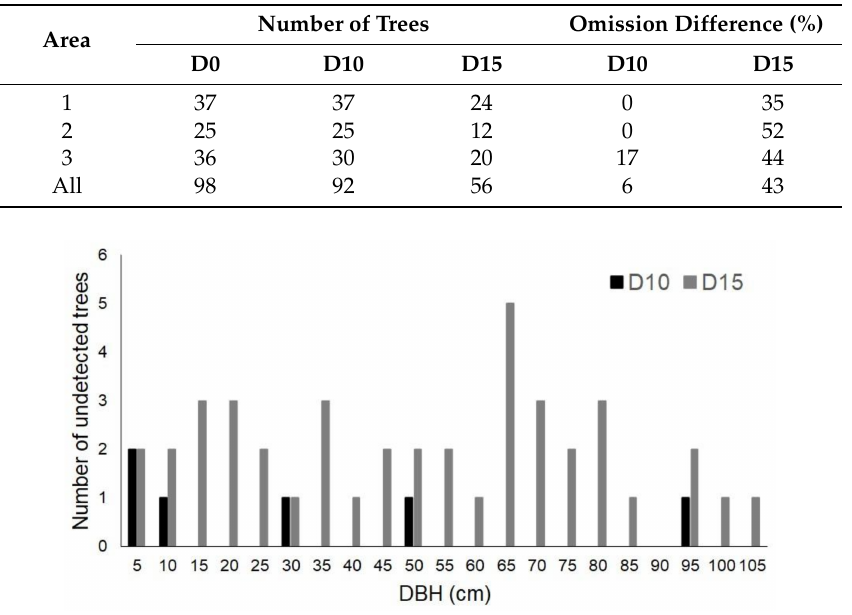
Figure 4. Stem number–diameter distribution of undetected trees by D10 and D15 scans. Data for all three areas are